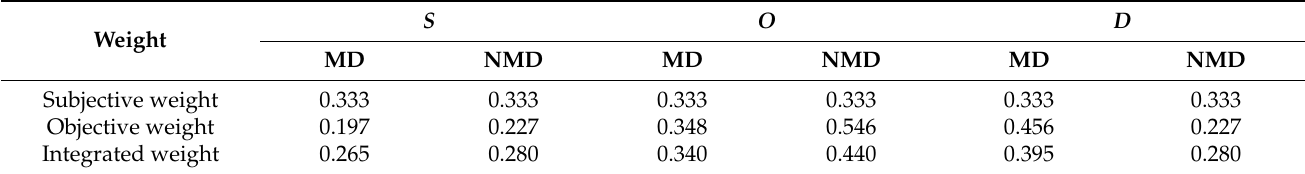
Table 9. Subjective weight, objective weight, and integrated weight of three different risk elements.